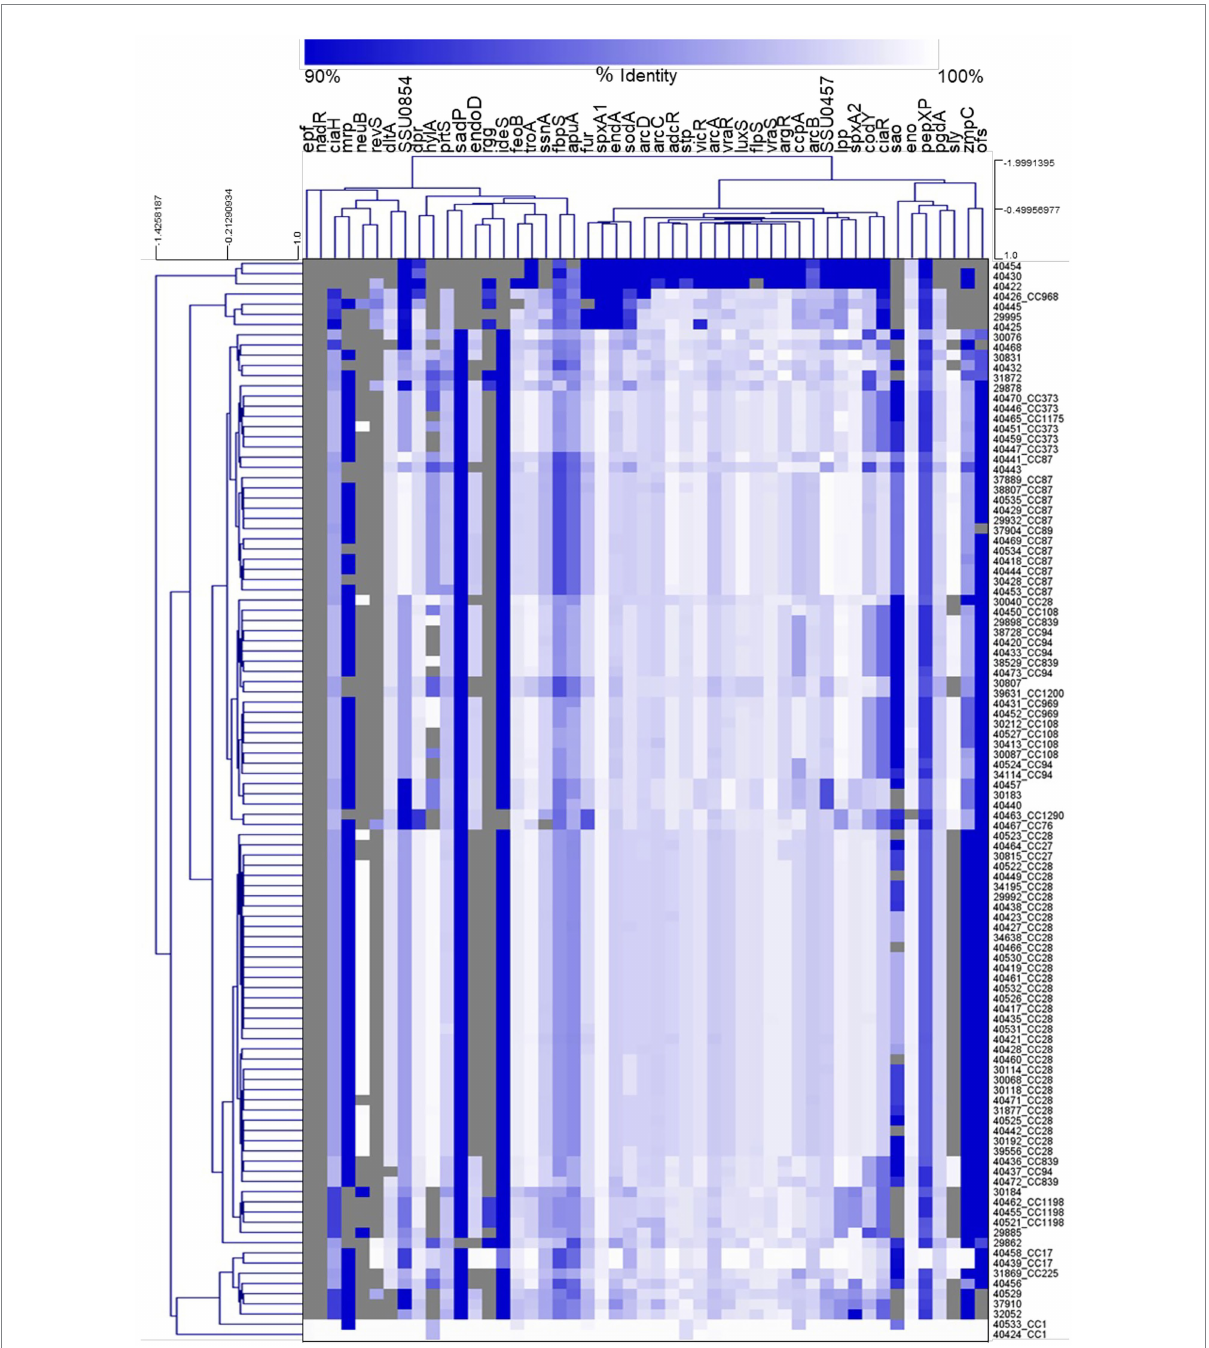
FIGURE 5 Hierarchical cluster heatmap displaying the relatedness of S. suis isolates based on the nucleotide percent identity of analyzed virulence genes. A distance matrix generated form the nucleotide percentage identity was converted into a heatmap and clustered by means of complete hierarchical clustering based on Pearson correlation distance for both genes and isolates. Gene names are provided at the top of the heat map and isolate names along with their corresponding CC are provided at the right side of heat map. Percent identity of analyzed genes (columns) from each isolate (rows) is represented using the color scale at top, while genes not present within an isolate are indicated by grey. Dendrograms are on the left side and on top of the heat